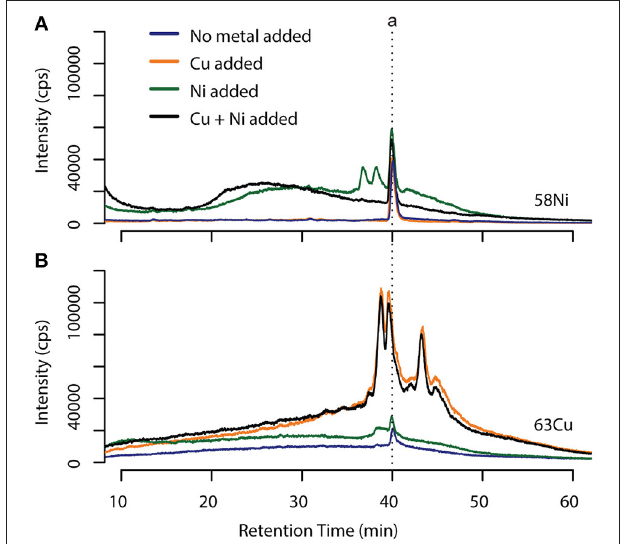
FIGURE 7 | LC-ICPMS chromatograms of 58 Ni and 63 Cu after the addition of excess citrate bound Cu and Ni to sample 6 followed by incubation for 12h. (A) Addition of Cu did not change the distribution of Ni ligands in this sample, while the addition of Ni resulted in the appearance of two Ni containing compounds. (B) Addition of Ni did not change the distribution of Cu compounds in the sample, while addition of Cu resulted in the appearance of a suite of Cu